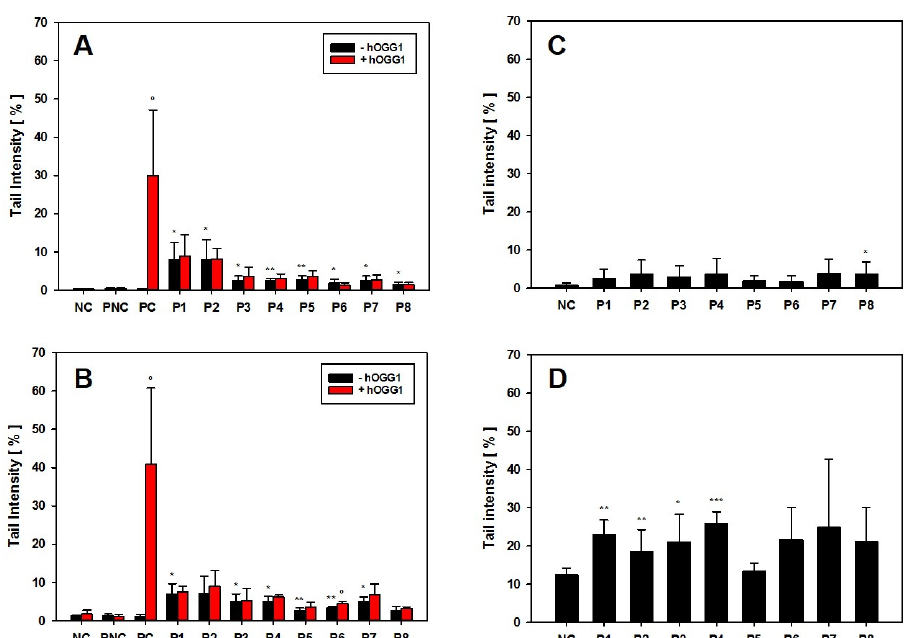
Figure 6. Genotoxicity screening of GRNP materials in AM, NR8383 cells and RAW 264.7 cells. ( A , B ) hOGG1-modified alkaline comet assay. AM ( A ) or NR8383 cells ( B ) were incubated for 24 h without (negative control, NC) or with 25 µg/cm 2 of P1–P8. Al 2 O 3 served as particle-like negative control (PNC) and KBrO 3 was used as positive methodological control. Data represent the arithmetic mean tail intensities (TI) ± SD of three independent experiments. Increase in TI on slides with hOGG1 treatment, compared to the respective slides without hOGG1, is indicative of oxidative DNA lesions. ( B , C ) Alkaline comet assay. AM ( C ) or RAW 264.7 cells were incubated for 24 h with or without the calculated BMD30 concentrations of P1–P8. Data represent the arithmetic mean TI ± SD of three independent experiments. For all experiments, the arithmetic mean was used as summarizing measure for the single-cell data on slides. */**/*** Statistically significant difference from PNC ( A , B ) or the respective NC ( C , D ): p ≤ 0.05, p ≤ 0.01 and p ≤ 0.001, respectively; Student’s t -test for unpaired values, two-tailed. ◦ Statistically significant difference from slides without hOGG1 treatment: p ≤ 0.05; Student’s t -test for paired values,